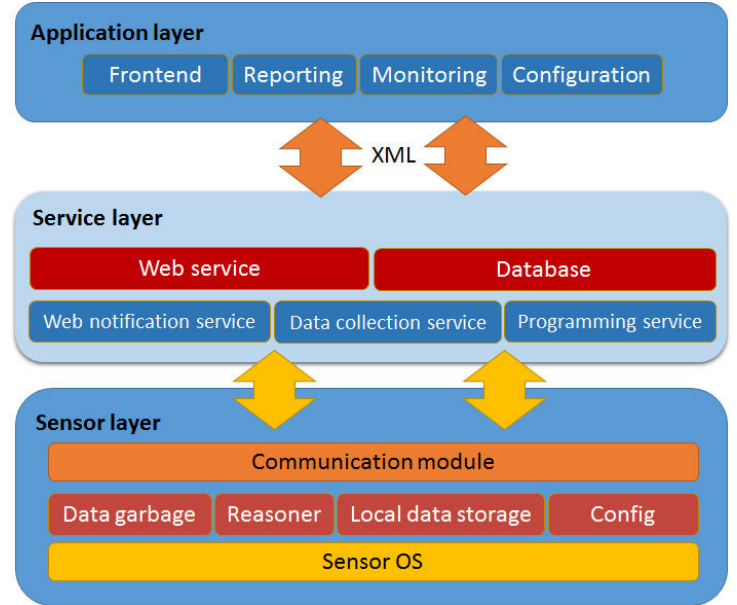
Figure 18. Software architecture of the monitoring system.